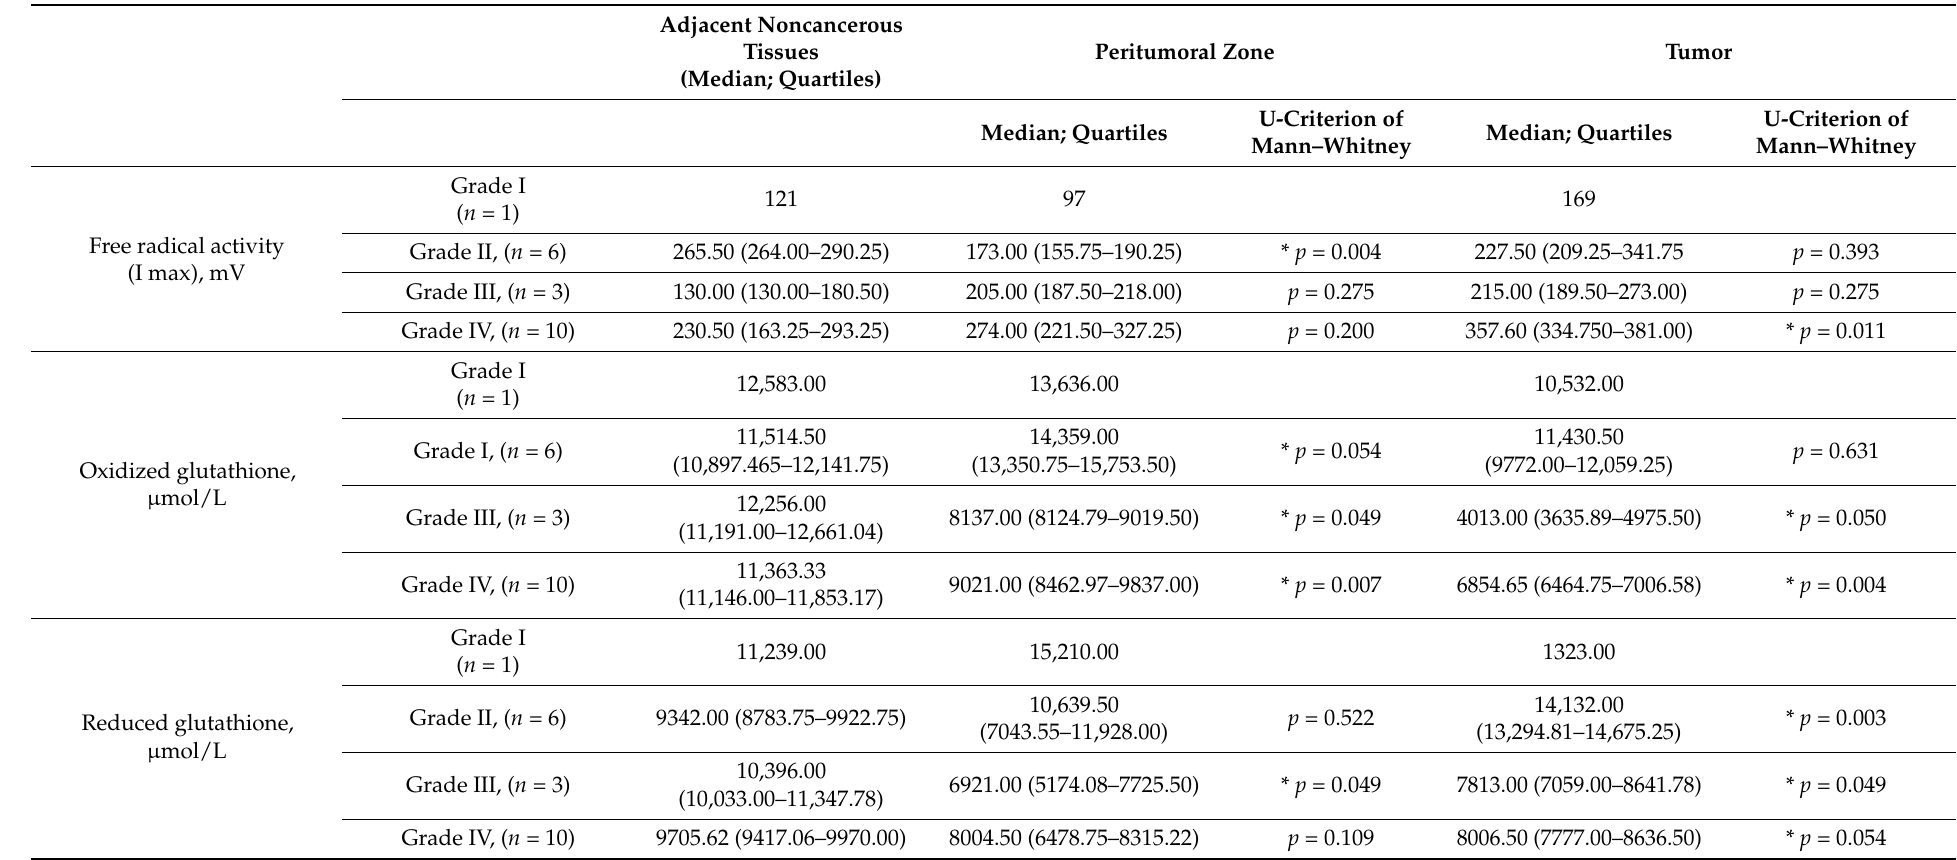
Table 1. Free radical activity, glutathione levels, and glutathione metabolism enzymes in gliomas, and indicators of glutathione metabolism in